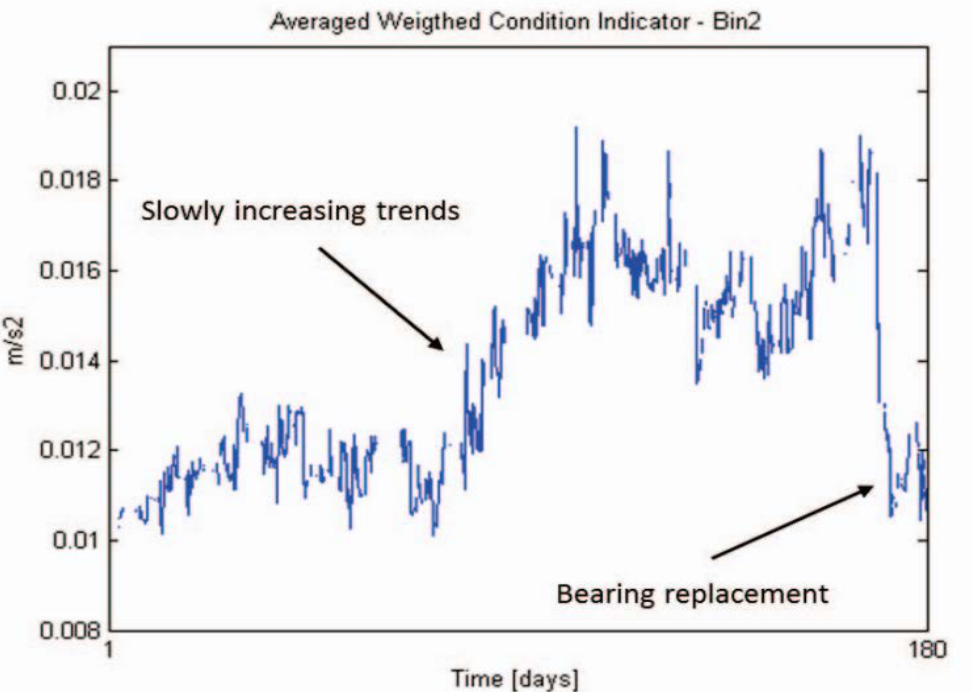
Figure 18. The behavior of the weighted average condition indication for bearing replacement. Reproduced with permission of [56]. Table 1. A summary of different conventional techniques for bearing fault